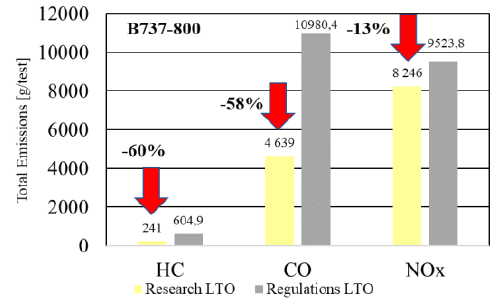
Fig. 12. Total emission of toxic exhaust fumes for adopted and regulations LTO for